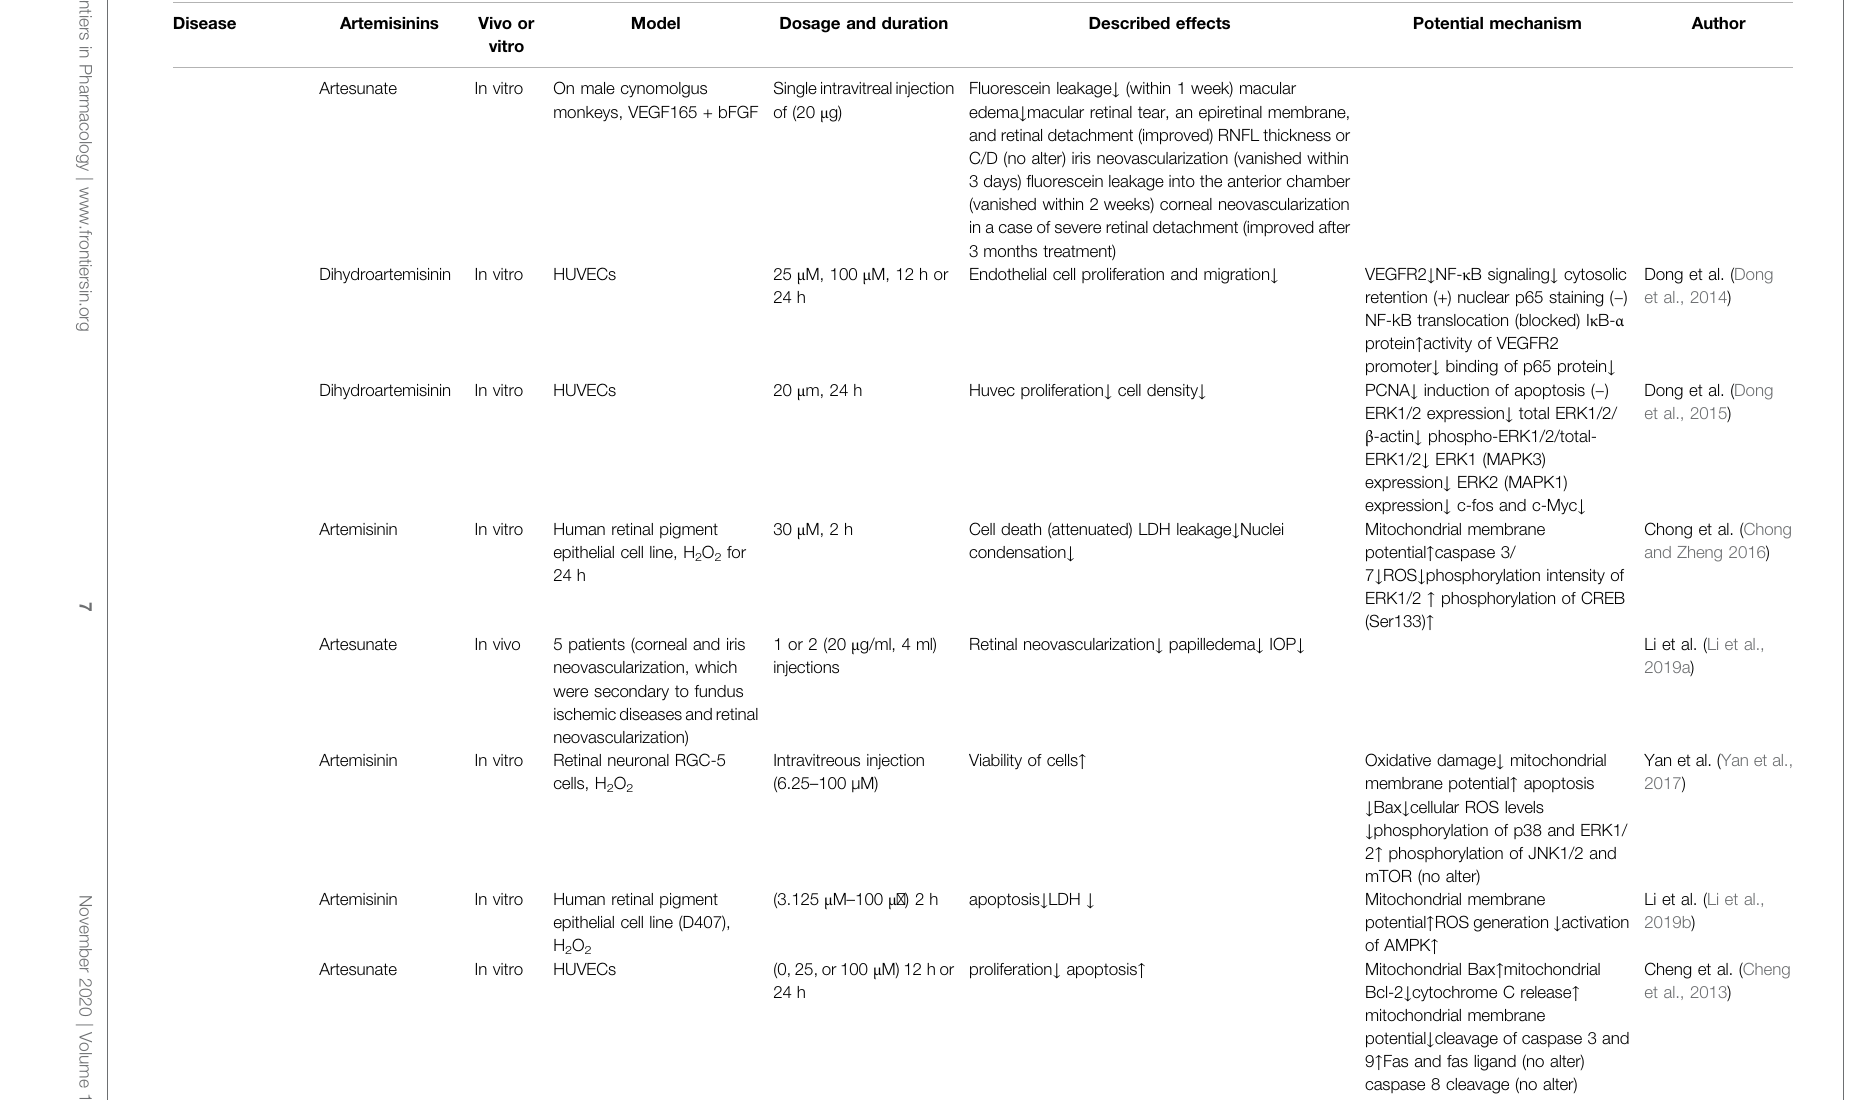
TABLE 2 | ( Continued ) Effects of Artemisinins on T2DM Associated